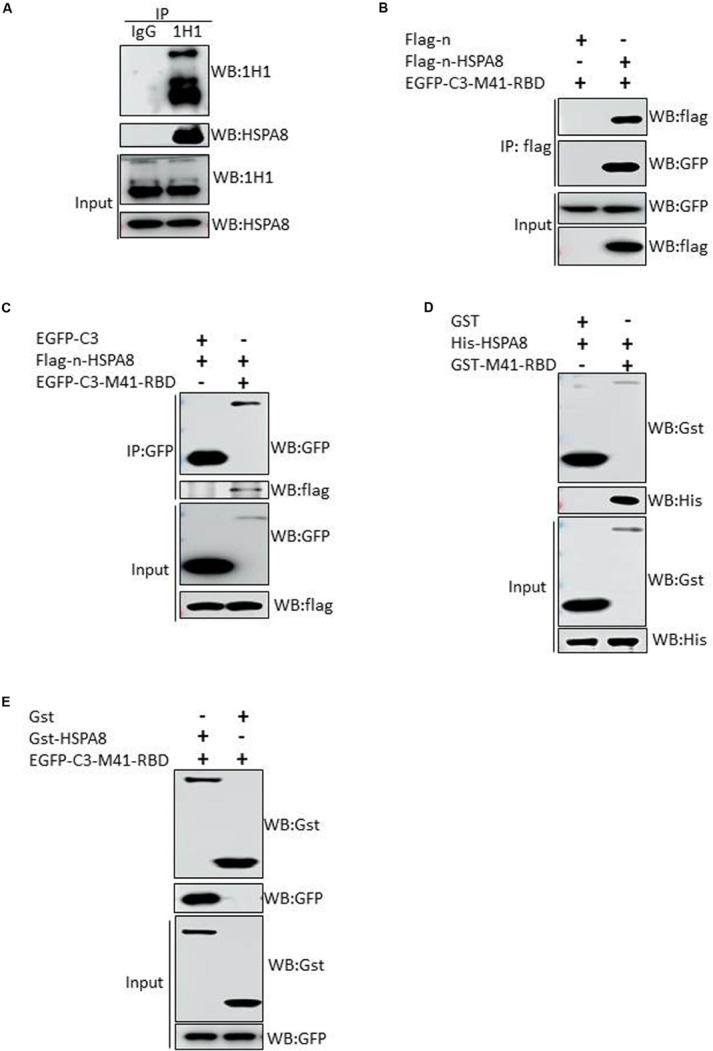
Interaction of HSPA8 with RBD of IBV spike protein. (A) Detection of the interaction between HSPA8 and IBV M41 spike protein in M41-infected CEK cells by immunoprecipitation assay using mAb 1H1 to IBV S and mouse IgG. IBV S1 and HSPA8 in precipitates were detected by immunoblots with mAbs to IBV S1 and HSPA8. (B) Detection of the interaction between HSPA8 and IBV M41-RBD by co-IP assay using HSPA8 as bait protein. 293T cells were cotransfected with indicated plasmids and then flag-tagged HSPA8 was immunoprecipitated with anti-flag antibody. The precipitated proteins were detected by Western blotting using anti-flag and anti-GFP antibodies. (C) Detection of the interaction between HSPA8 and IBV M41-RBD by reciprocal co-IP assay using M41-RBD as bait protein. 293T cells were cotransfected with indicated plasmids and then GFP-tagged M41-RBD was immunoprecipitated with anti-GFP antibody. The precipitated proteins were detected by Western blotting using anti-flag and anti-GFP antibodies. (D,E) Identification of the direct interaction between HSPA8 and IBV M41-RBD by GST-pull-down assay. In (D), GST and GST-M41-RBD recombinant proteins were separately bound to glutathione-sepharose beads and then incubated with His-HSPA8 recombinant protein. The protein complexes were detected by Western blot analysis with antibodies against GST and 6xHis. In (E), The lysates of 293T cells transfected with EGFP-C3-M41-RBD vector were incubated with GST or GST-HSPA8 protein which was separately bound to glutathione-sepharose beads. Subsequently, the protein complexes were detected by Western blot analysis with antibodies against GST and GFP.